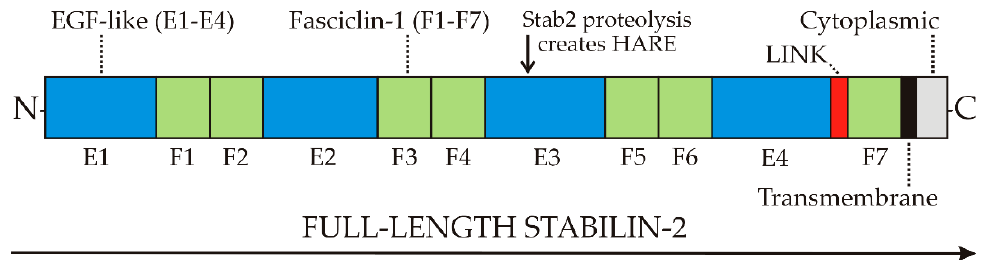
Figure 2. Human Stab2 domain organization. Full-length Stab2 is a type I membrane protein [17] of 2551 aa with a large N-terminal extracellular domain, a 92 aa HA-binding Link module (red), a 22 aa transmembrane domain (TMD, black), and a 72 aa C-terminal cytoplasmic domain (CD, gray). The ectodomain contains 7 Fasciclin-1 domains (F1–F7; green) and 4 larger EGF-like domains (blue; E1–E4) spanning the ectodomain length. Multiple binding sites for phosphatidylserine (PS) and for α M β 2 and α v β 5 integrins are within the E1-E4 and F1–F7 domains, respectively. PS binding sites enable receptor recognition of dying apoptotic cells [18] and integrin-binding sites enable receptor recognition of lymphocytes [19] in coordination with PS interactions [20]. A proteolytic cleavage site (arrow) that generates the 190 kDa HARE isoform at Ser 1136 [21] is within Fasciclin-1 domain 4 (F4). This constitutive cleavage process gives two half-receptors: a soluble N-terminal half, whose fate